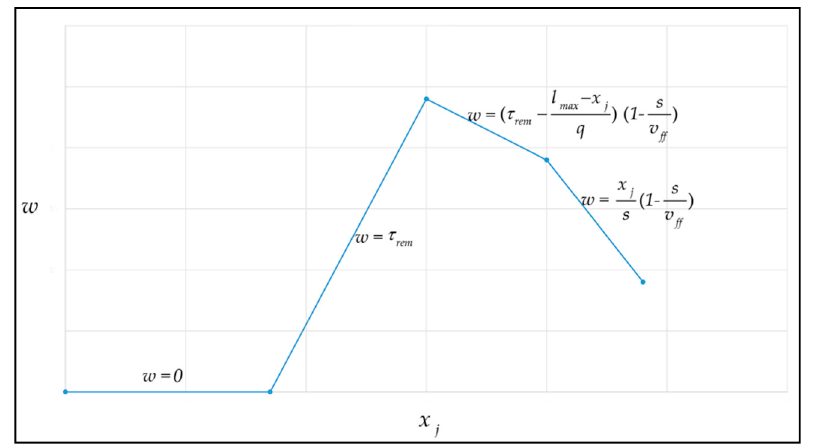
Figure A1. Delay w as a function of x j in Case 2.